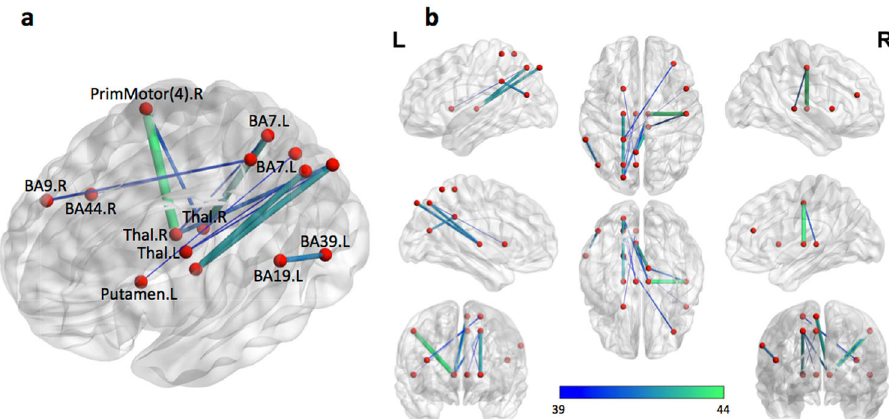
Fig. 4 Map of 13 stable (supervoxel-level) links common to all subsets of 30 top-ranked (lowest p -value) links, over 95 different CV-folds (leave- one-subject out data subsets). a Custom view. b Full view of the links presented in a . The color bar shows – ln( p -value). Labels show the Brodmann areas (BA) corresponding to the end nodes. X , Y , Z coordinates of the nodes in the MNI space are given in Supplementary Table S7. A summary of links is presented in Supplementary Table S9 (see also Supplementary Fig. S9 for a reference map of all BAs)